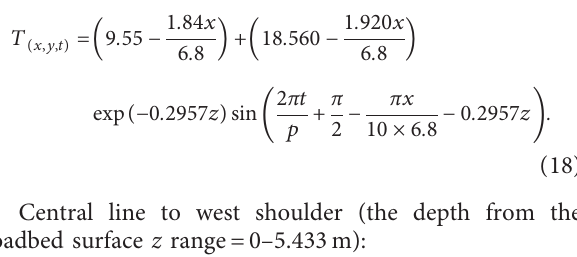
Figure 2: Location, composition, and measurement arrangement of the observed section. (a) Location of the observed section. (b) Composition and arrangement of measured points of roadbed